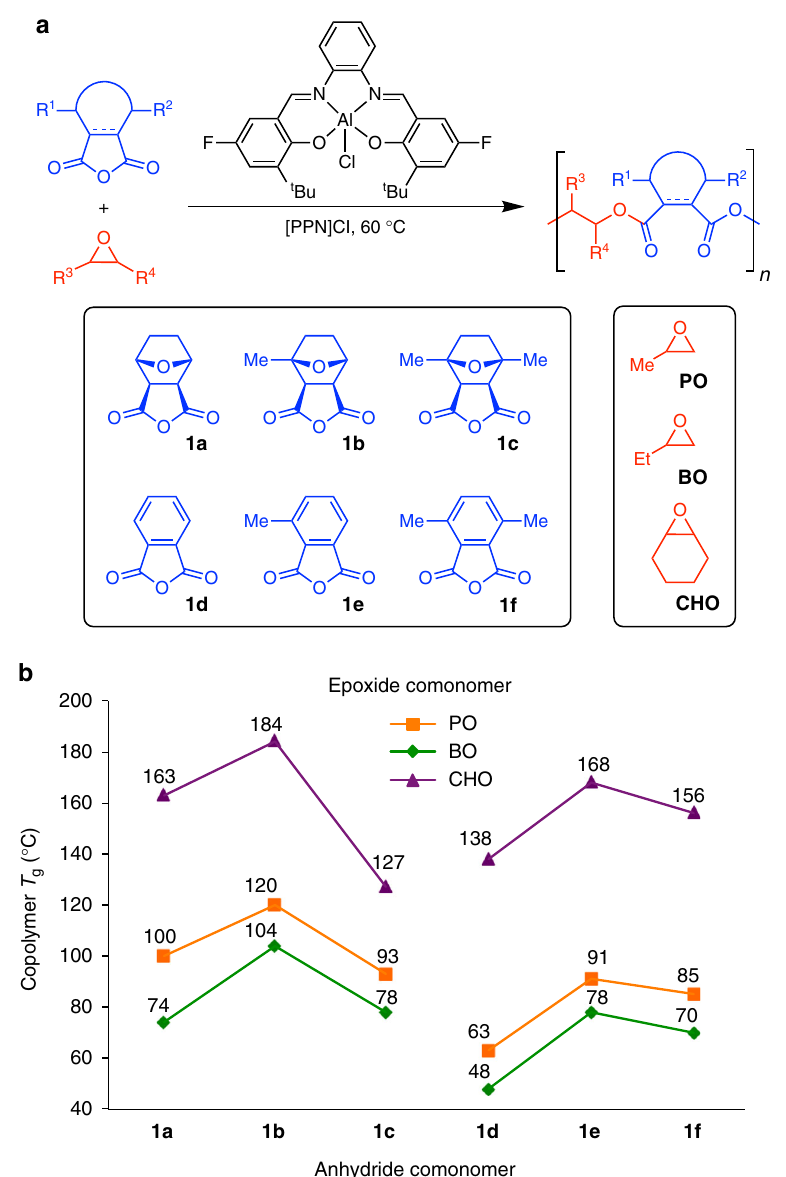
Fig. 2 Polymer synthesis and thermal properties. a Cyclic anhydride and epoxide comonomers investigated in this work. b Observed T g values for copolymers made from the PO, BO, and CHO epoxides and the tricyclic ( 1a – 1c ) or phthalic ( 1d – 1f ) anhydride